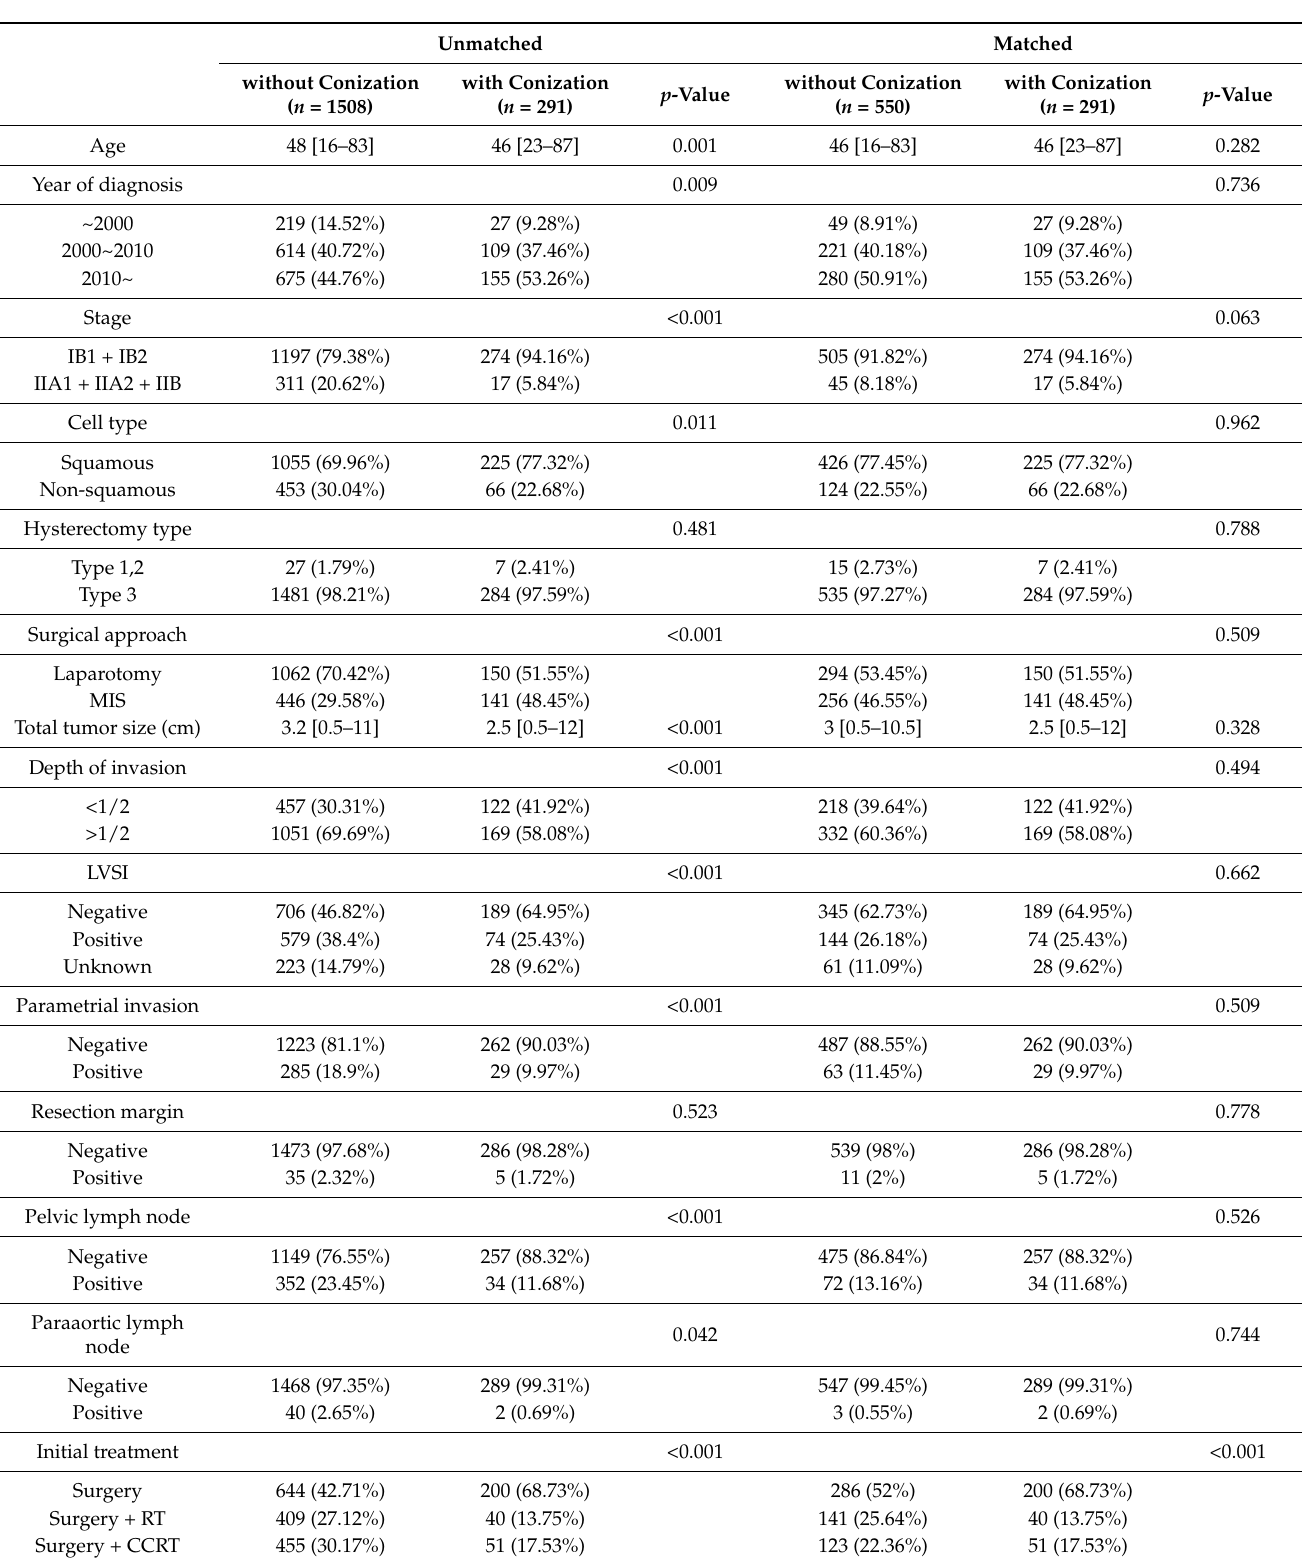
Table 1. Patients’ baseline characteristics before and after propensity score